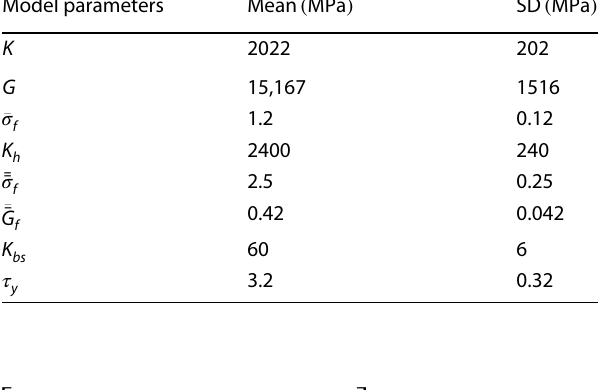
Table 3 Prior (log-normal) probability distribution of model param- eters: mean value and standard